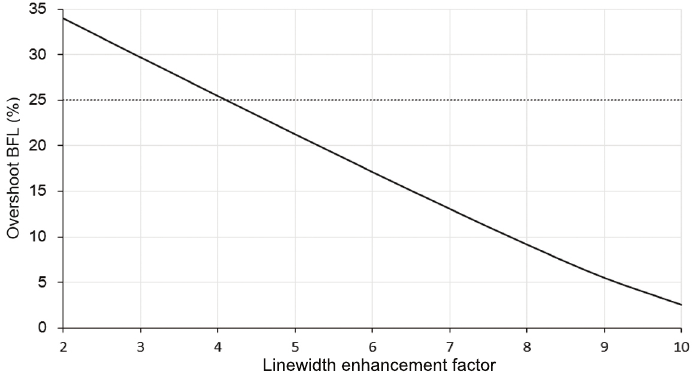
Figure 10. Overshoot at BFL output for different BFL detuning values. The dotted horizontal line denotes the OVS acceptable limit set at 25%.